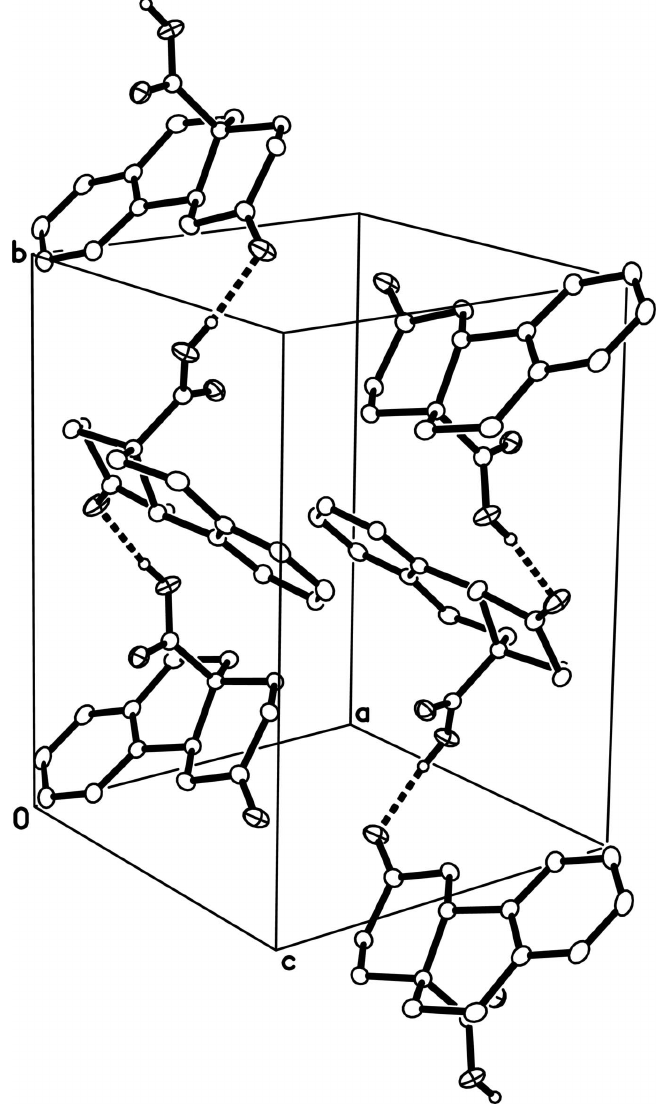
A partial packing diagram for (I), with extracellular molecules, illustrating a counter-directional pair of parallel H- bonding chains. For clarity, all C-bound H atoms are omitted. Displacement ellipsoids are drawn at the 30% probability